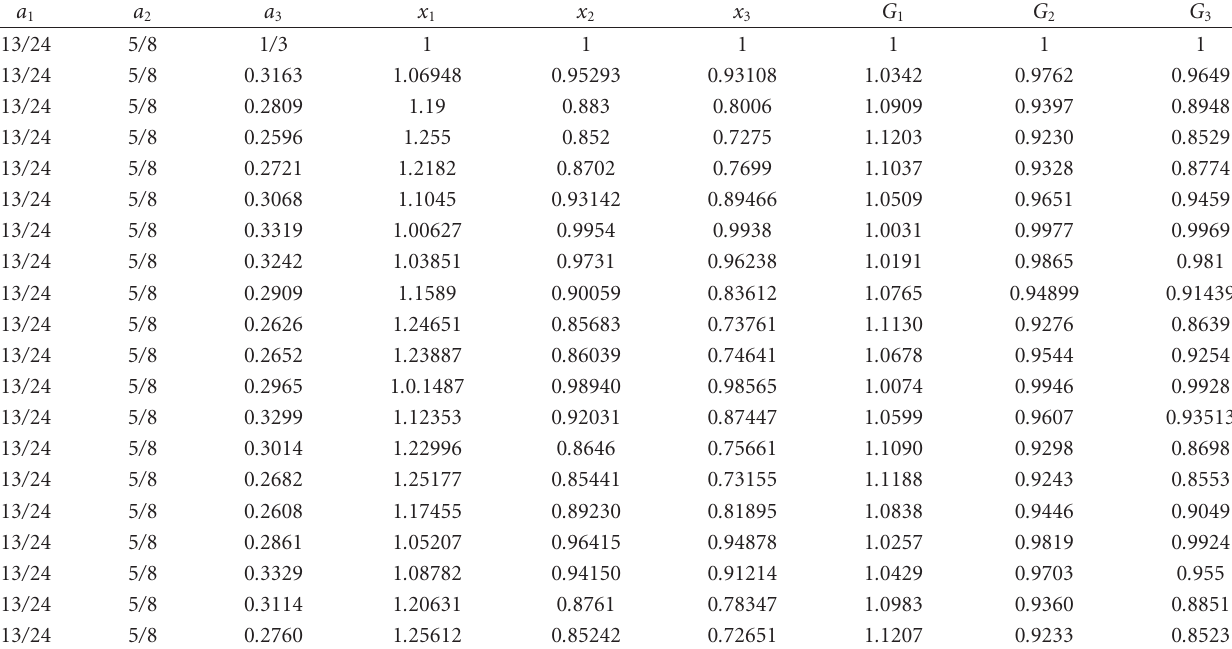
Table 2: Filter coe ffi cients and